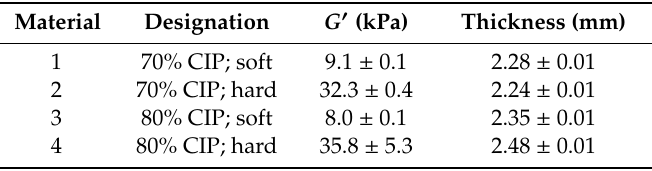
Table 1. A list of the investigated materials and their